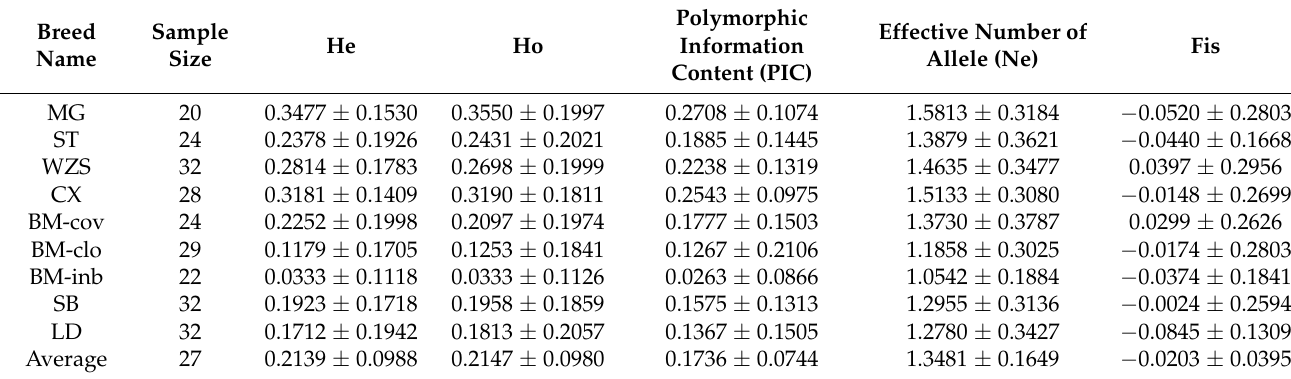
Table 2. Genetic parameters generated by the 30 SINE RIPs in all eight pig breeds.